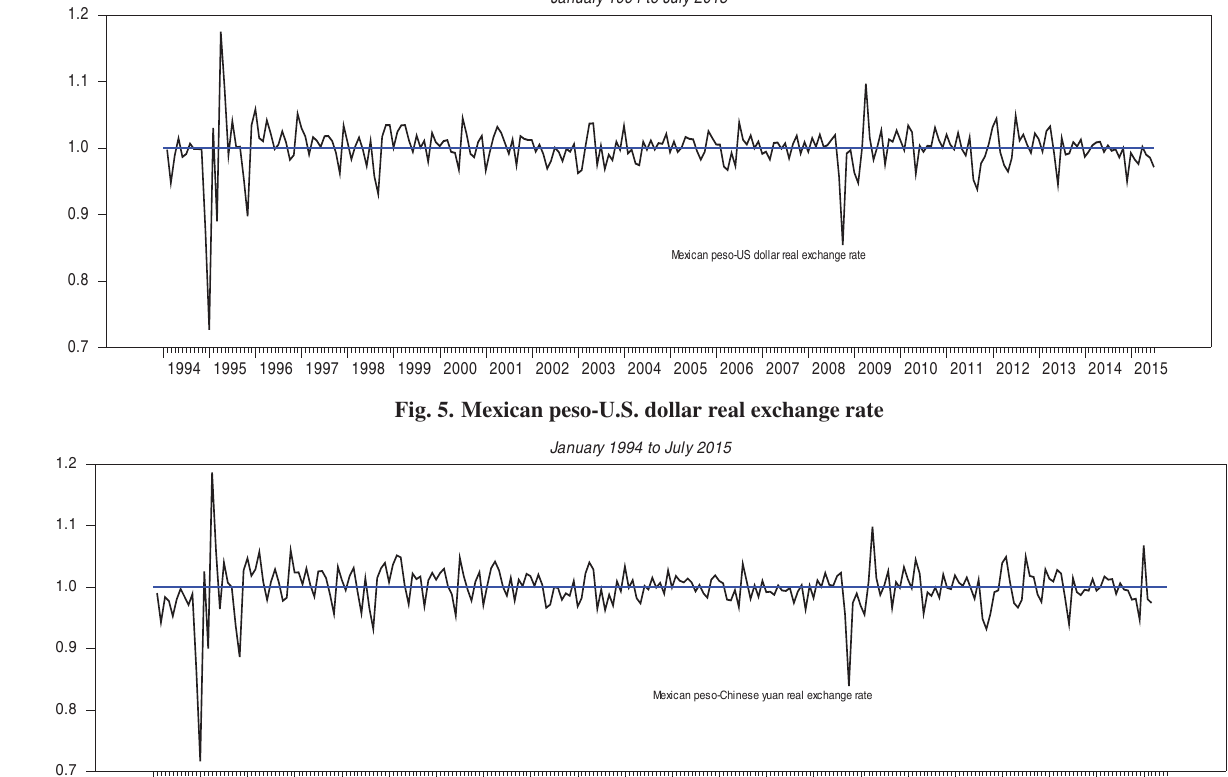
Fig. 6. Mexican peso-Chinese yuan real exchange